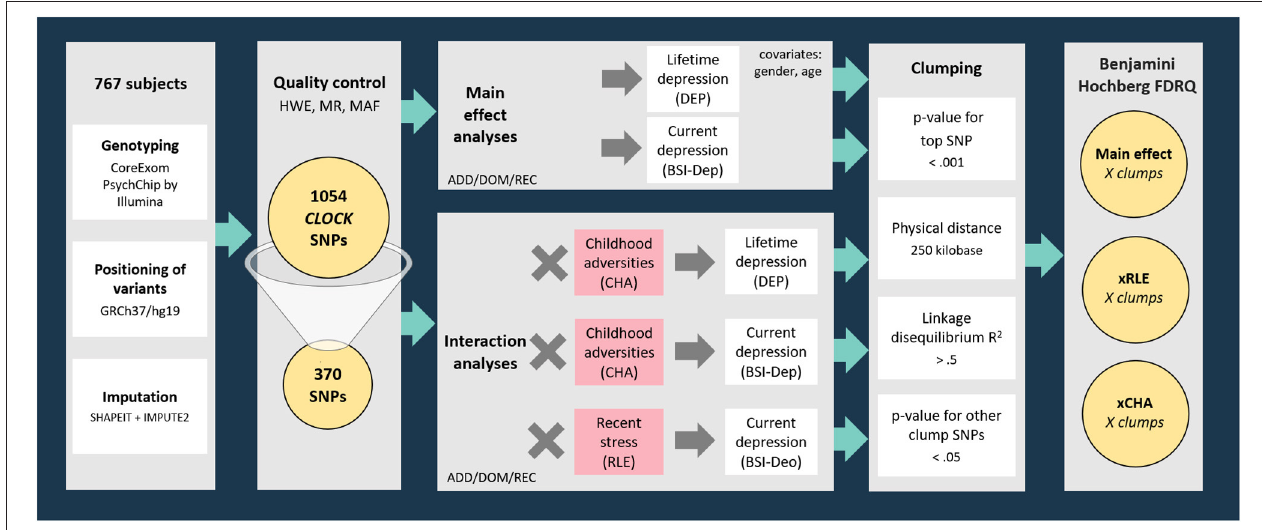
FIGURE 1 | Methods of investigating the effects of variation in CLOCK in interaction with childhood adversities and recent life events on lifetime and current depression: study population, quality control steps, and statistical analyses. RLE, recent life events; CHA, Childhood adversities; BSI-Dep, Brief Symptom Inventory depression score; ADD, additive model; DOM, dominant model; REC, recessive model; HWE, Hardy-Weinberg Equilibrium; MR, missingness rate; MAF, minor allele frequency; DEP, lifetime depression; FDRQ, False Discovery Rate Q